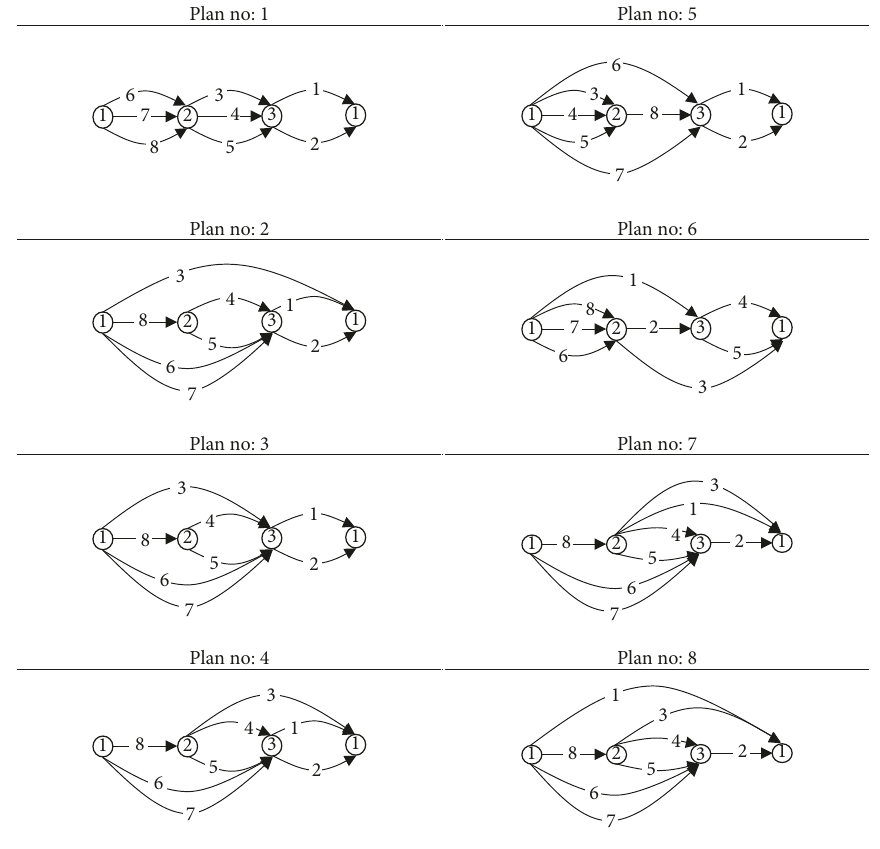
Figure 3: Movement-based cycle diagrams relating to created possible 8 phase